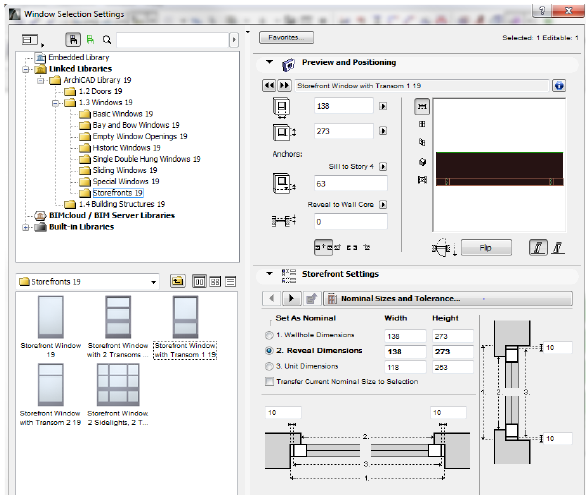
Fig. 6: Parametric window in ArchiCAD . The information about the window could be modified by the users.